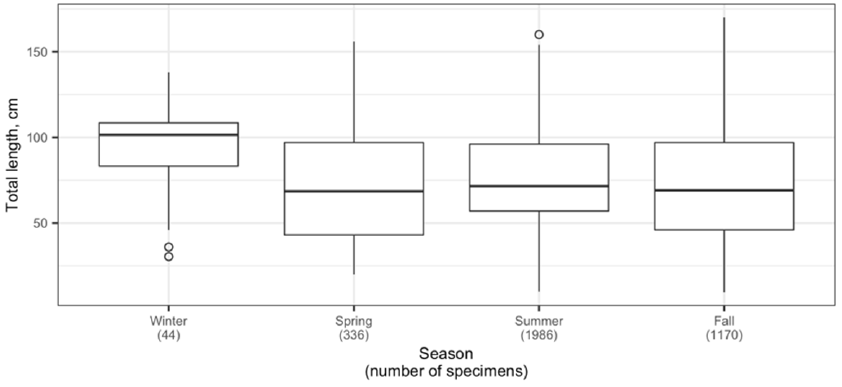
Figure 12. Changes in total length of the Aleutian skate Bathyraja aleutica from the North Pacific by time of year. Circles denote outliers.